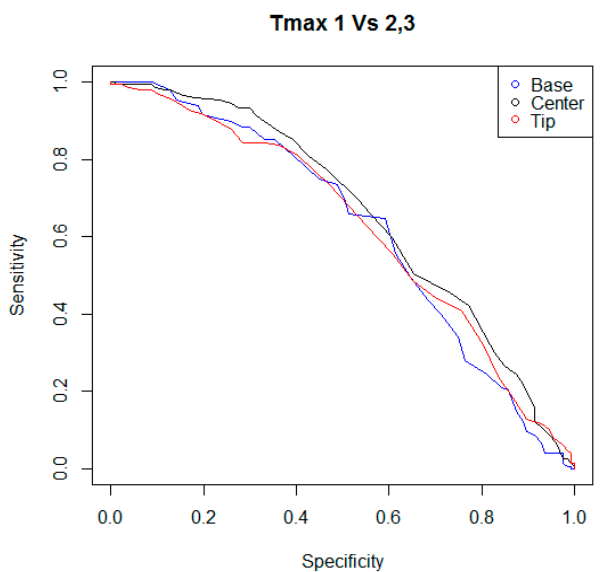
Figure 6. ROC curves of the statistical tests that were built considering the performances of the indicators T max,B , T max,C , and T max,T , and different possible cutoff levels. Teat status was considered as “mechanically stressed” when its scoring fell in the level “two” or “three” of the color change scale adopted.